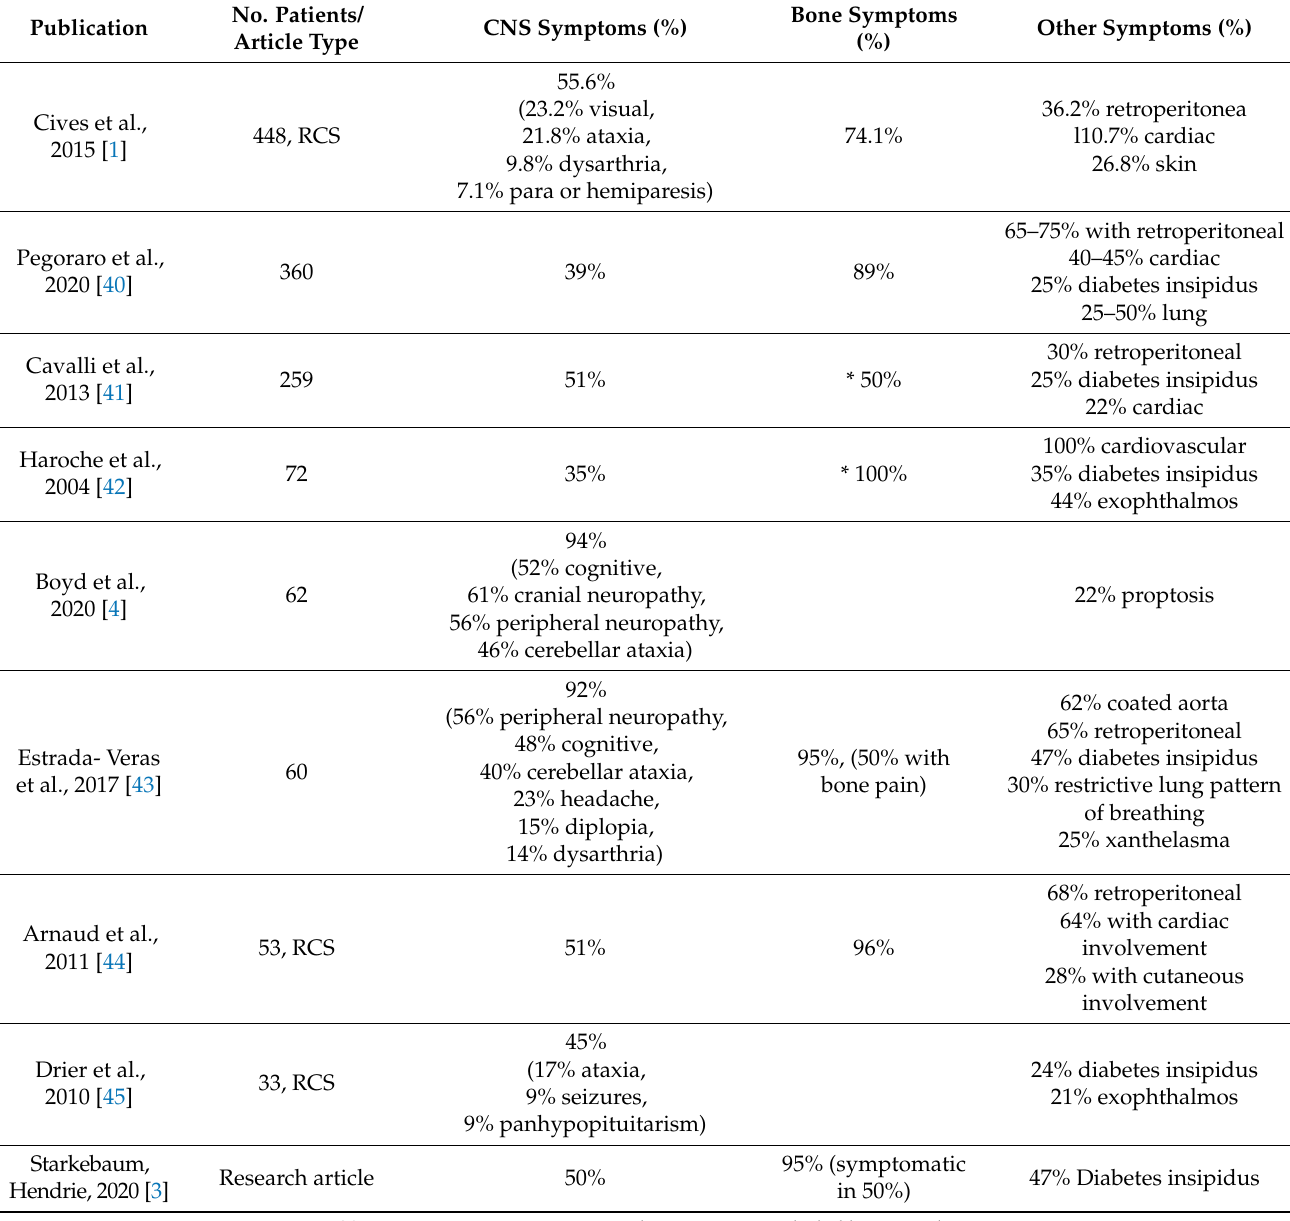
Table 4. Frequency of CNS, bone, and other system involvement in ECD as reported in the